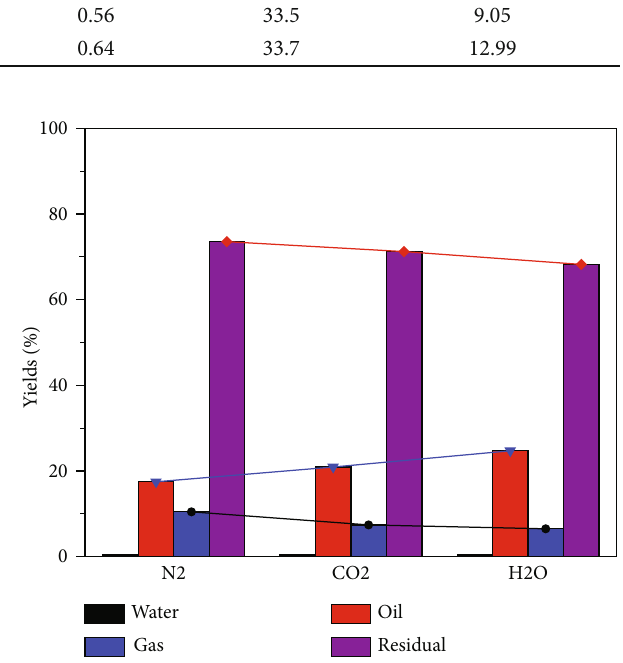
Figure 3: Product distribution of JM oil shale in di ff erent